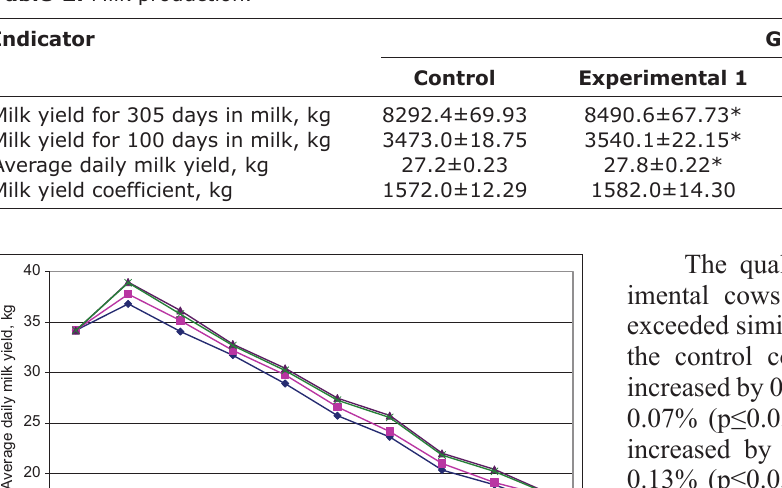
Table-2: Milk production.